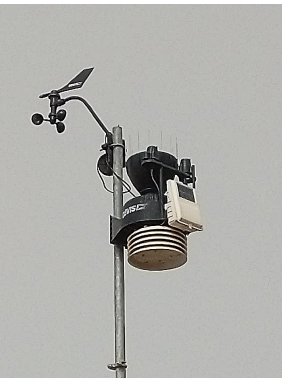
Figure 4. Rooftop Weather